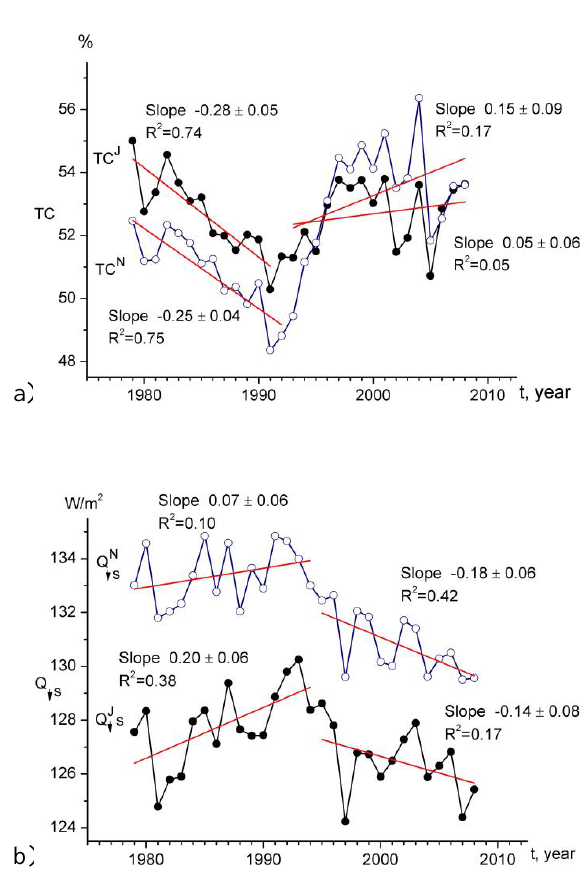
Fig. 2. The temporal variability of total cloud cover ( TC ) (a) and downward shortwave radiation at the surface Q ↓ s (b) over ATR using JRA-25 reanalysis for the period 1979–2008. Symbols “J” and “N” in superscript indicate values. Calculated by JRA-25 and NCEP/DOE AMIP-II respectively.